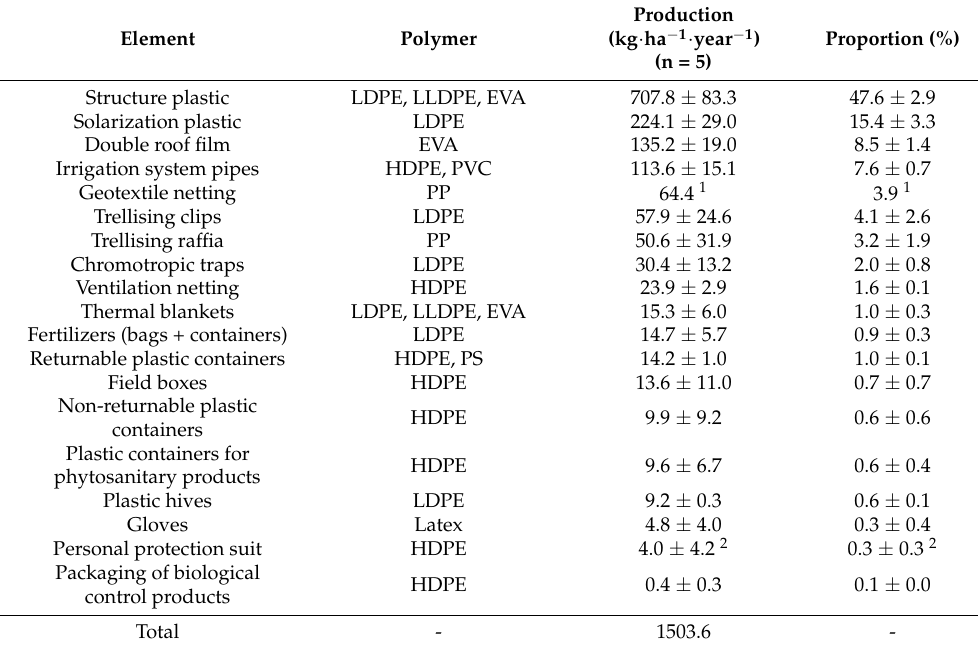
Table 3. Estimation of the production and proportion of agricultural plastic waste/by-products by element and total in the greenhouse production system in the province of Almeria. Values (mean ± standard